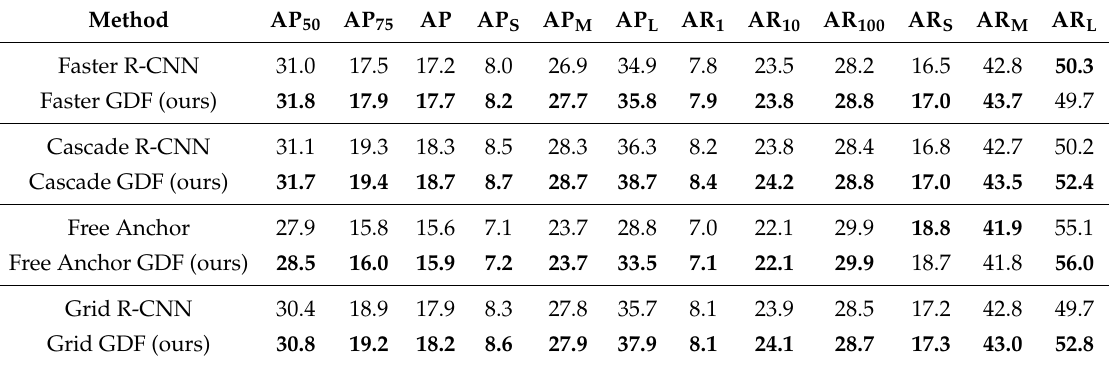
Table 1. Comparisons of detection performance on the VisDrone